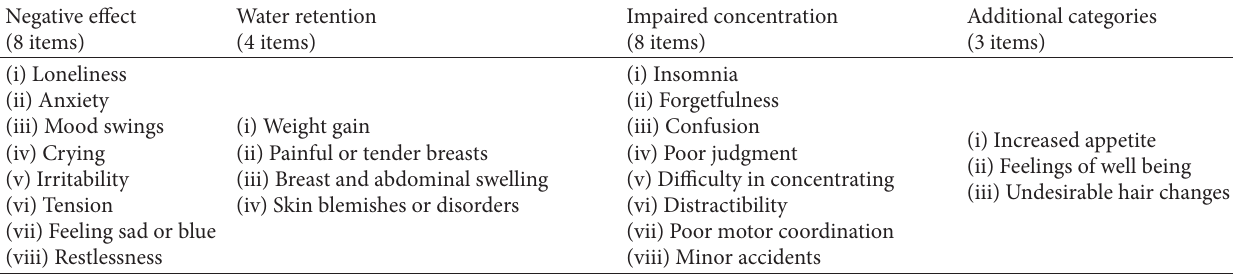
Table 2: Categories (6) and items (23) in each main category of WHAQ scores.